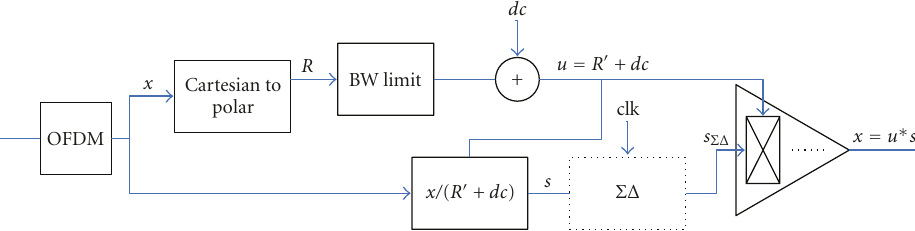
Figure 9: The new transmitter architecture. The ΣΔ clk operates at the carrier frequency and gives an amplitude and phase output for each RF cycle.